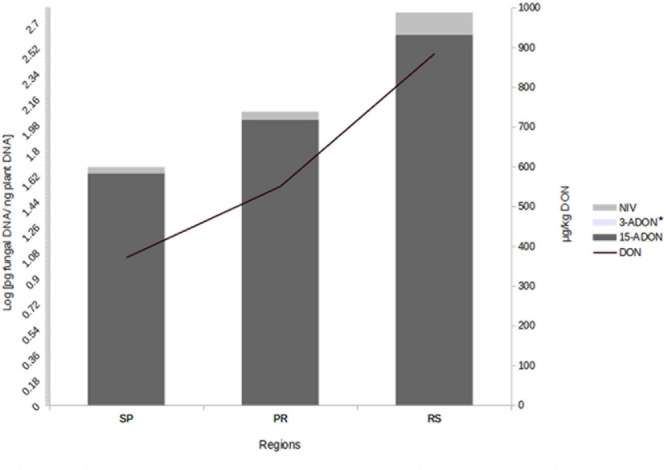
Mean DNA concentration of trichothecene genotypes and deoxynivalenol (DON) in wheat grains from different regions of Brazil.
∗3-ADON levels are not seen due to low concentration (Levels are: SP – 0.004, PR – 0.0026, RS – 0.001 pg fungal DNA/ng plant DNA).